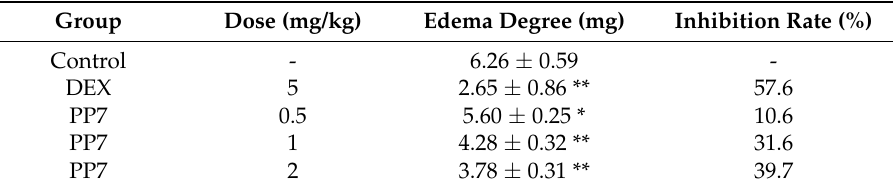
Table 1. Effect of PP7 on xylene-induced ear edema in mice.